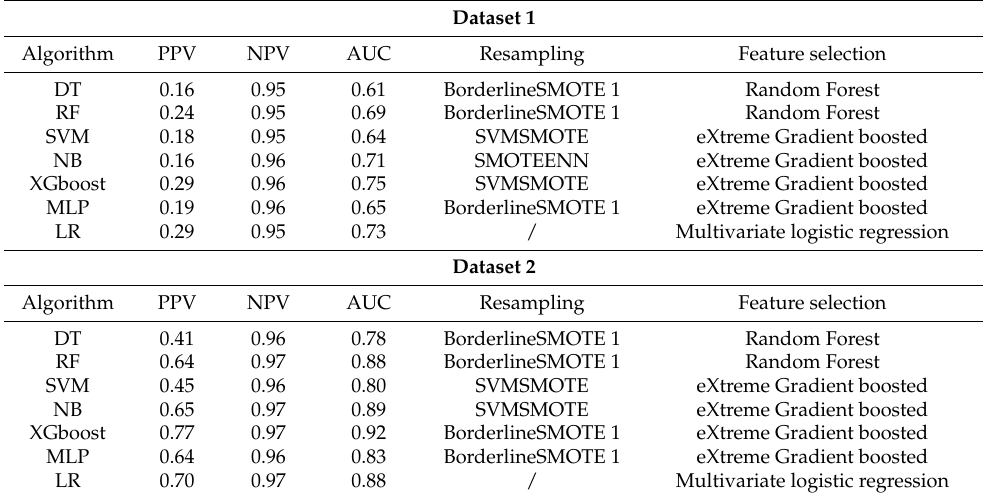
Table 4. Classifiers’ predictive performance in the validation cohort for the two